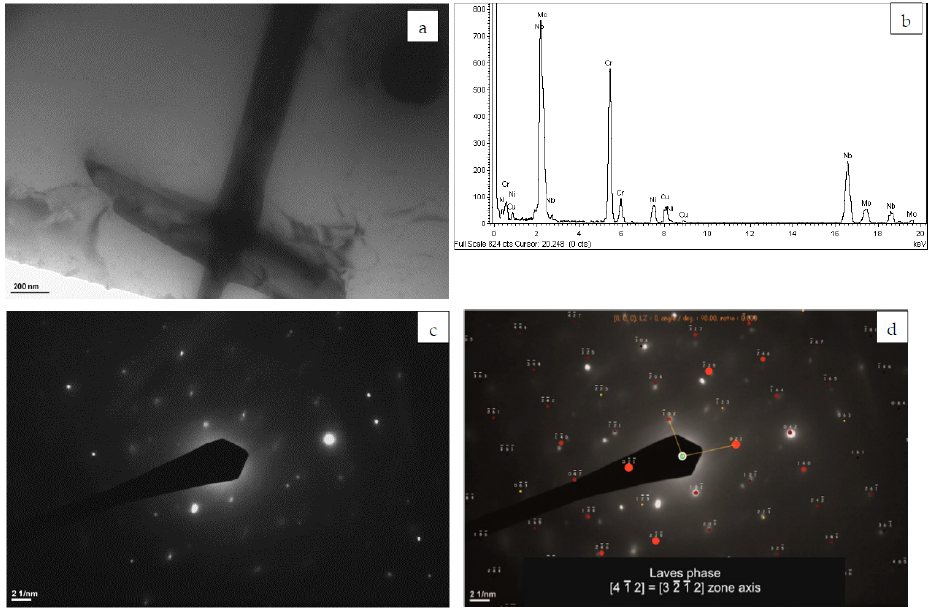
Figure 4. ( a ) TEM image of the Laves phase precipitate; ( b ) the corresponding EDS spectrum; ( c ) SAED pattern; and ( d ) its solution for the Laves phase [4 ⎯ 1 2] zone axis.